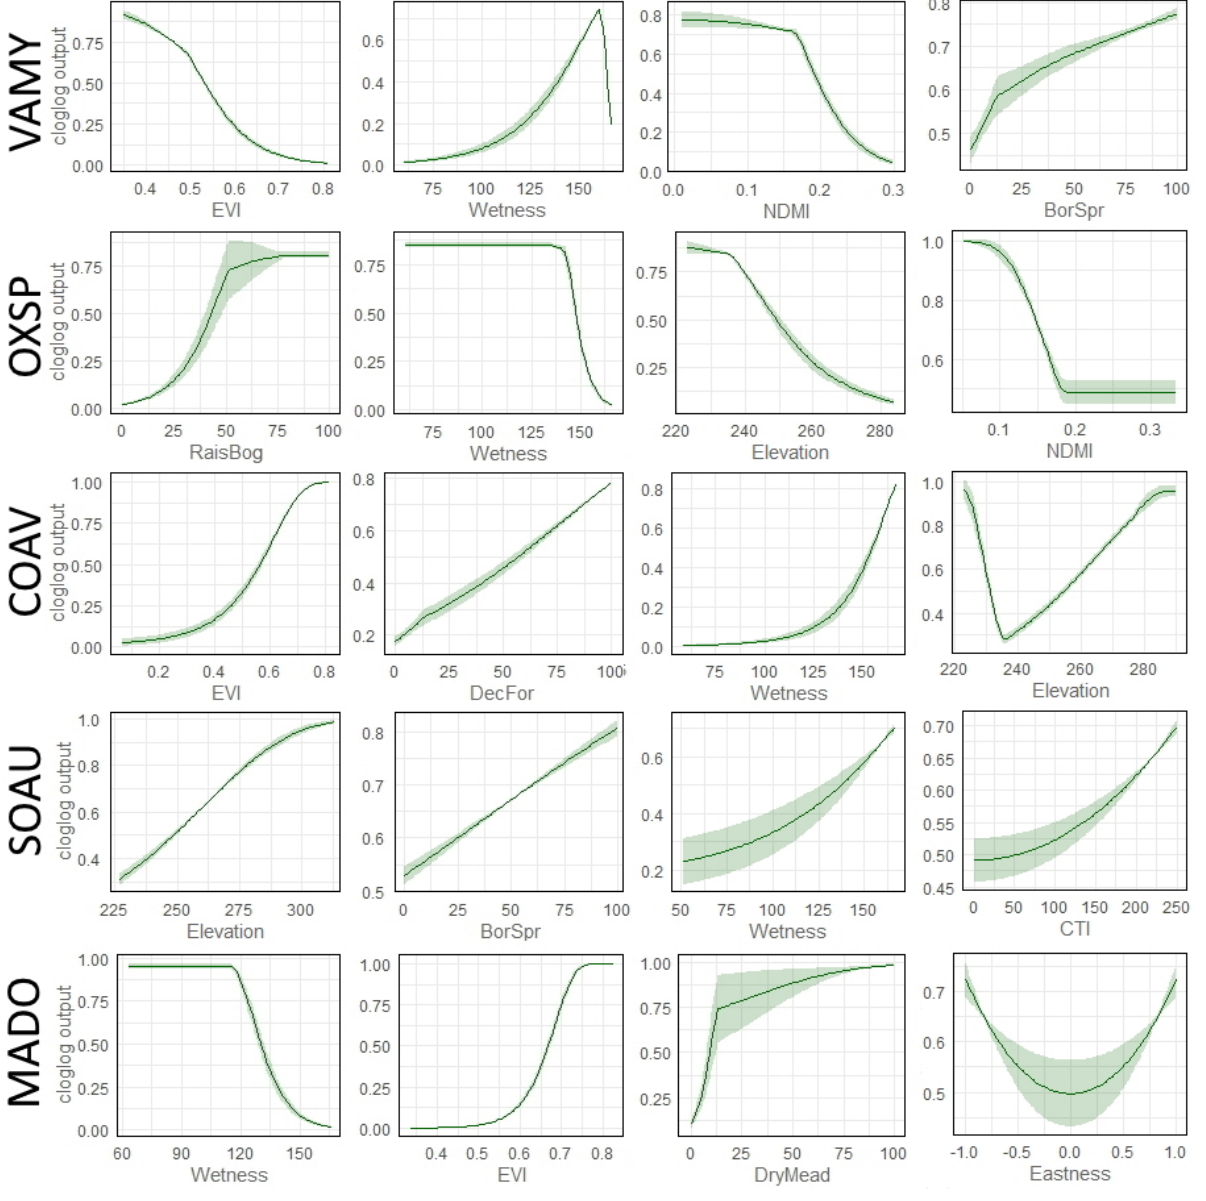
Figure A4. Response curves for the four most important variables of the brown bear fruit food-probability models (soft and hard mast) in the Central Forest State Nature Reserve and its buffer zone (European Russia) in 2008–2020. Designations: VAMY— Vaccinium myrtillus , OXSP— Oxycoccus spp., COAV— Corylus avellana , SOAU— Sorbus aucuparia , and MADO— Malus domestica . The curves show the mean response of the ten cross-validation MaxEnt runs and the mean ± one standard deviation. EVI—enhanced vegetation index; NDMI—normalised difference moisture index; Wetness—tasseled cap wetness; Elevation—elevation (m a.s.l.); Eastness—eastness (aspect) from the digital elevation model; CTI—compound topographic index; BorSpr—proportion of boreal spruce forests (%); SphFor—proportion of Sphagnum spruce–pine forests (%); DecFor—proportion of deciduous forests (mixed small-leaved forests) (%); RaisBog—proportion of raised bogs (%); DryMead—proportion of dry meadows (%). Units of the variables are shown in Table 1 of the main text.